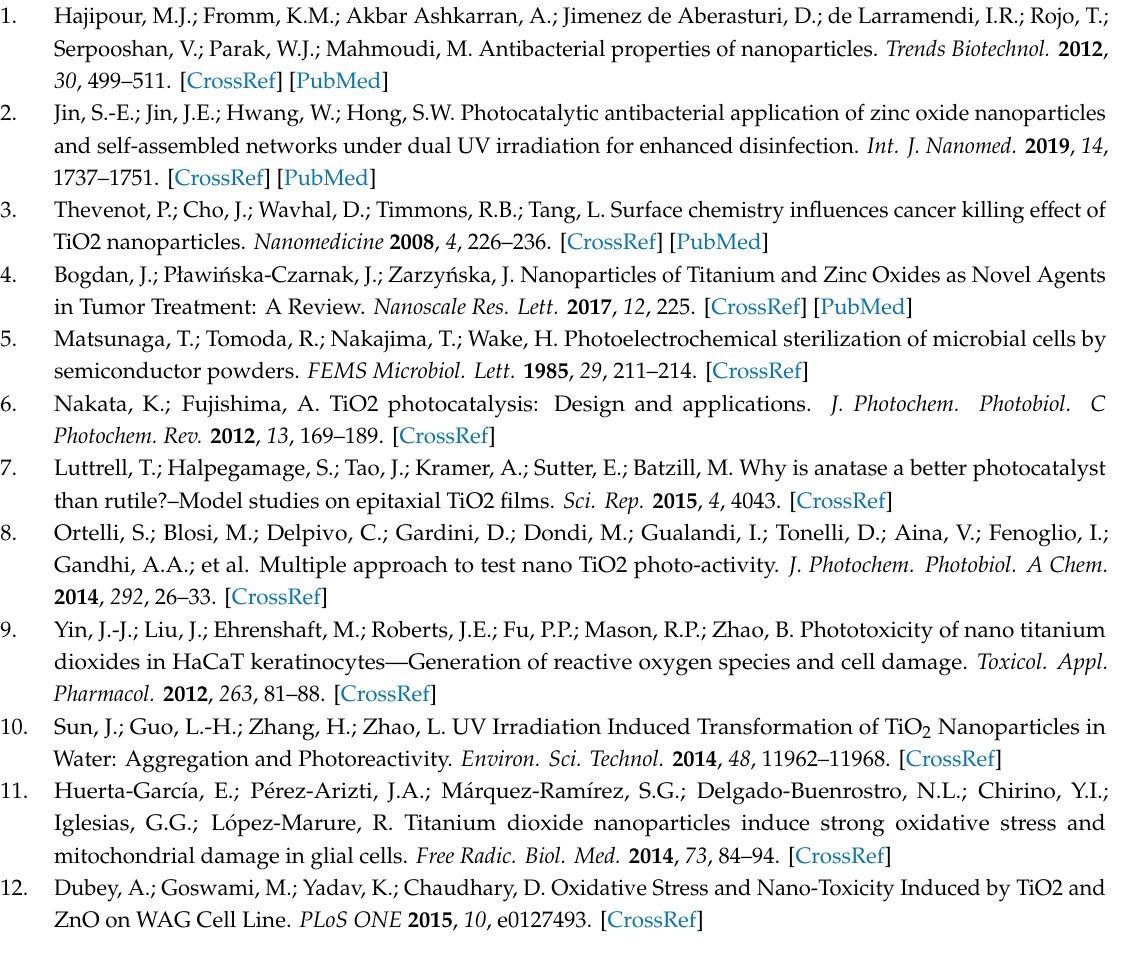
Figure S1: TEM images of a) TiO 2 and b) SiO 2 nanoparticles. Figure S2: Cell viability was assessed by MTT test after 24h of exposure to increasing doses of TiO 2 (dark grey bars) and SiO 2 (grey bars) NPs. Figure S3: Hoechst / PI test and Annexin V / PI assay for the evaluation of necrotic and apoptotic cells. Figure S4: Oxidative stress was evaluating by detecting ROS in A549 after 180 min of exposure to TiO 2 and SiO 2 NPs (75 µ g / mL) and positive control H 2 O 2 (100 µ M) by using the fluorescent probe DCFDA. Figure S5: Autophagy was investigated through the analysis of the expression of LC3B II protein by cytofluorimeter. Figure S6: Morphology of cells after exposure to 75 µ g / mL of TiO 2 . Figure S7: Morphology of cells after exposure to 75 µ g / mL of TiO 2 . Figure S8: Cells and NPs interactions after exposure for 24h to TiO 2